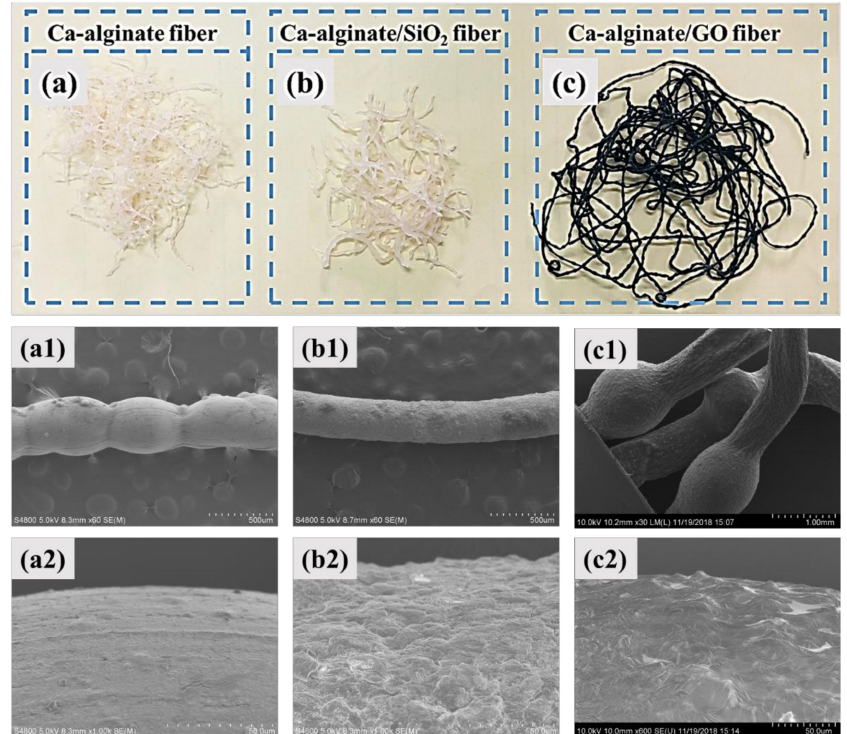
Figure 2. Morphology of the three kinds of self-healing fiber: Optical morphologyof Ca-alginate fiber ( a ), Ca-alginate / SiO 2 fiber ( b ) and Ca-alginate / GO fiber ( c ); Micromorphology of Ca-alginate fiber ( a1 , a2 ), Ca-alginate / SiO 2 fiber ( b1 , b2 ) and Ca-alginate / GO fiber ( c1 , c2 ).